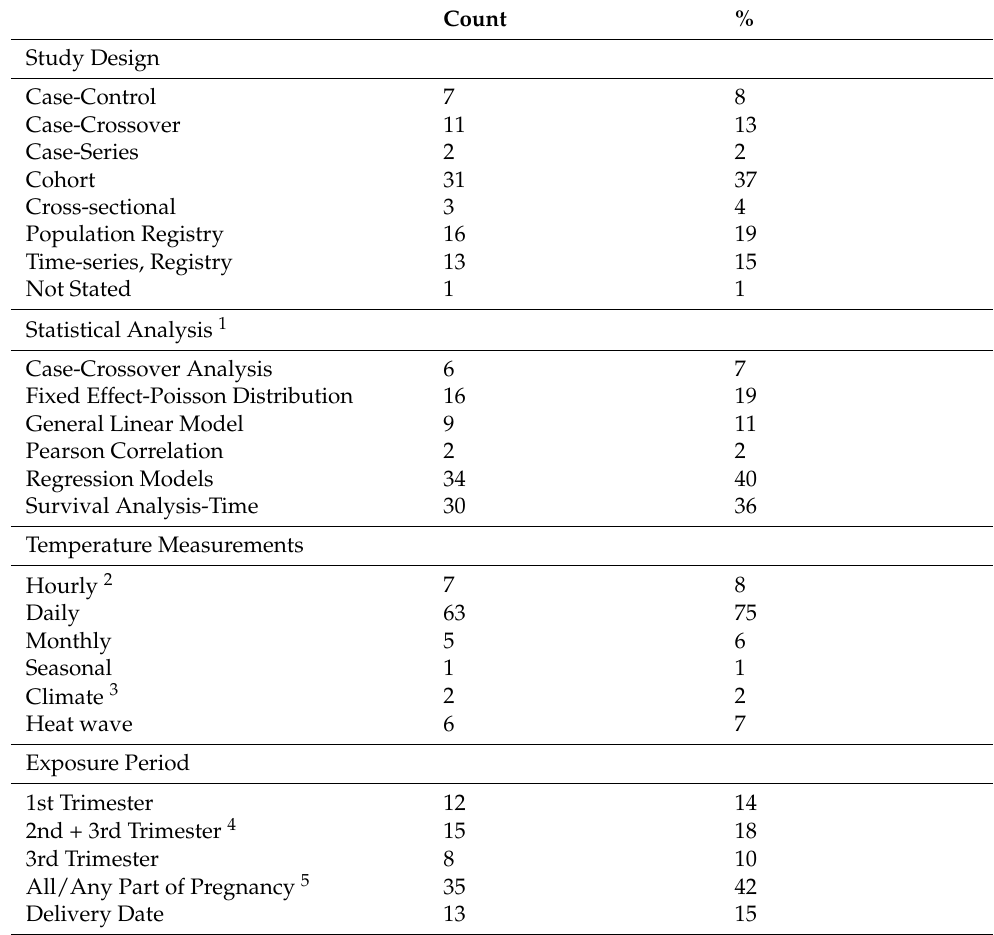
Table 2. Summary of study methodologies n =